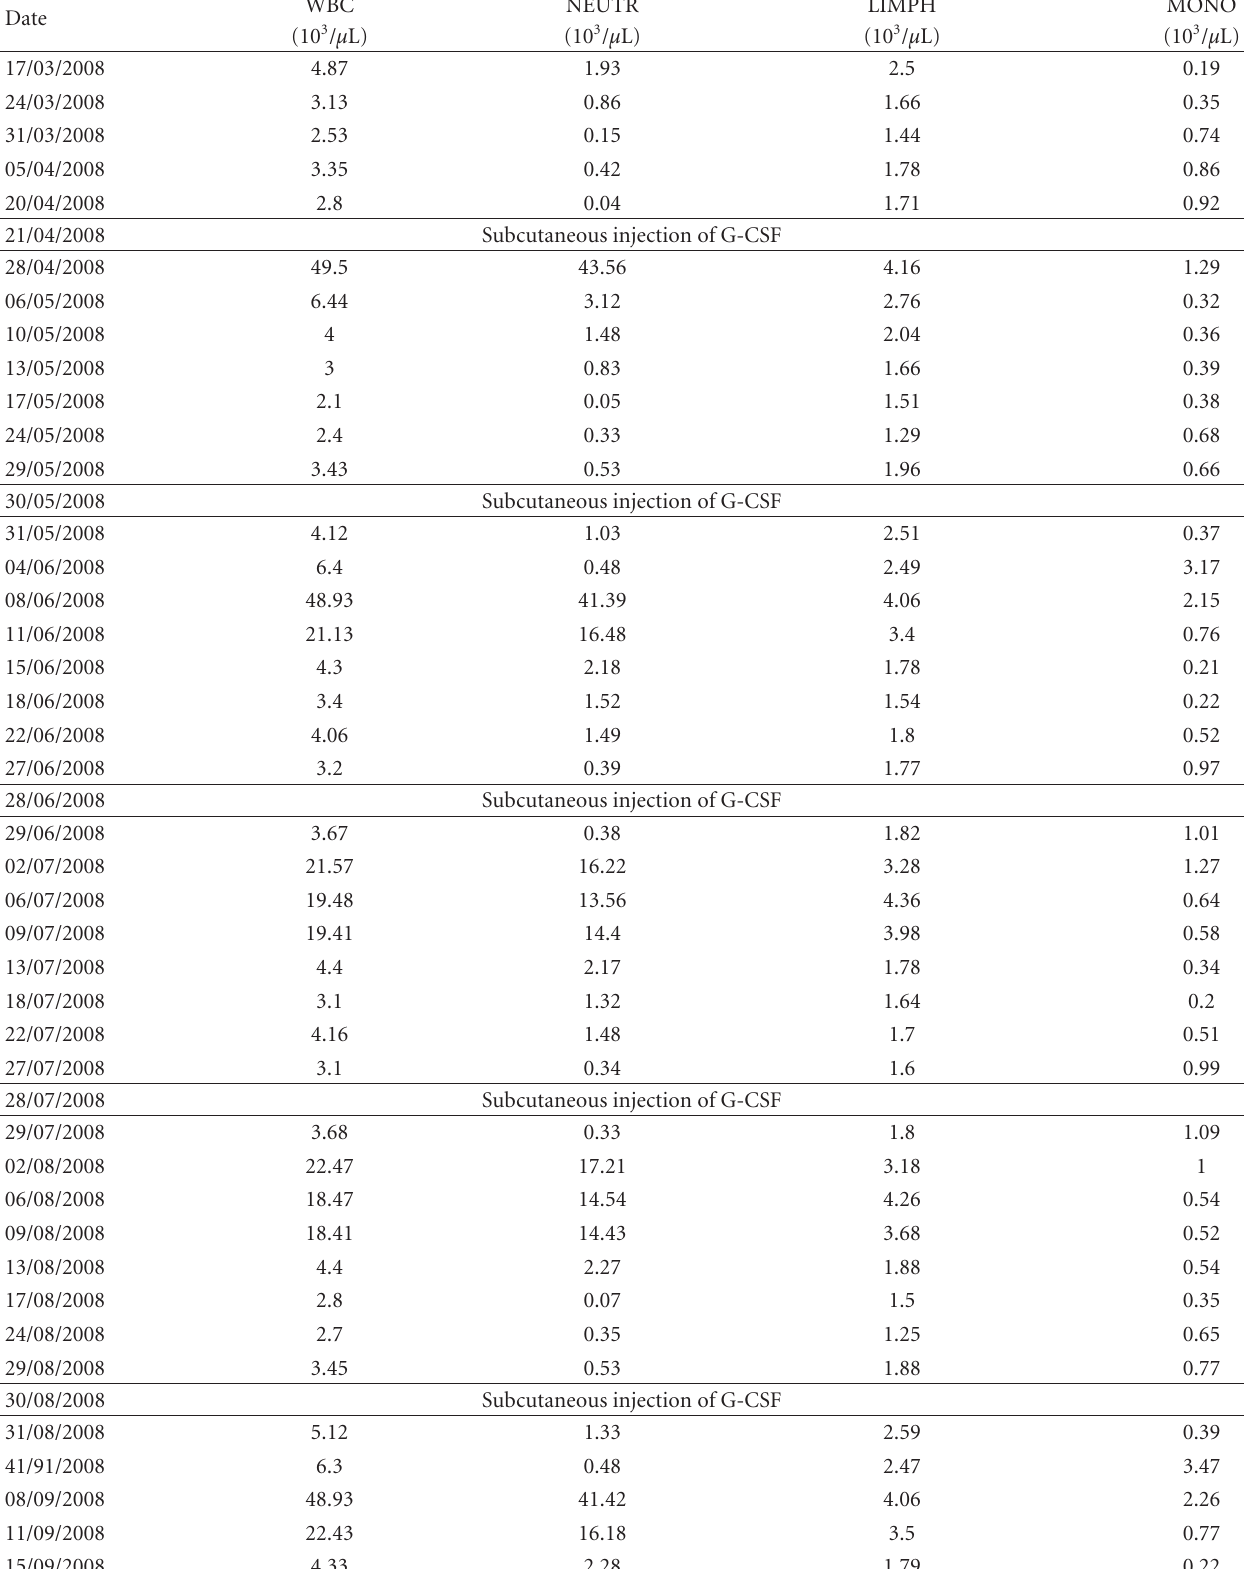
Table 1: Haematological examinations during G-CSF therapy (March—September